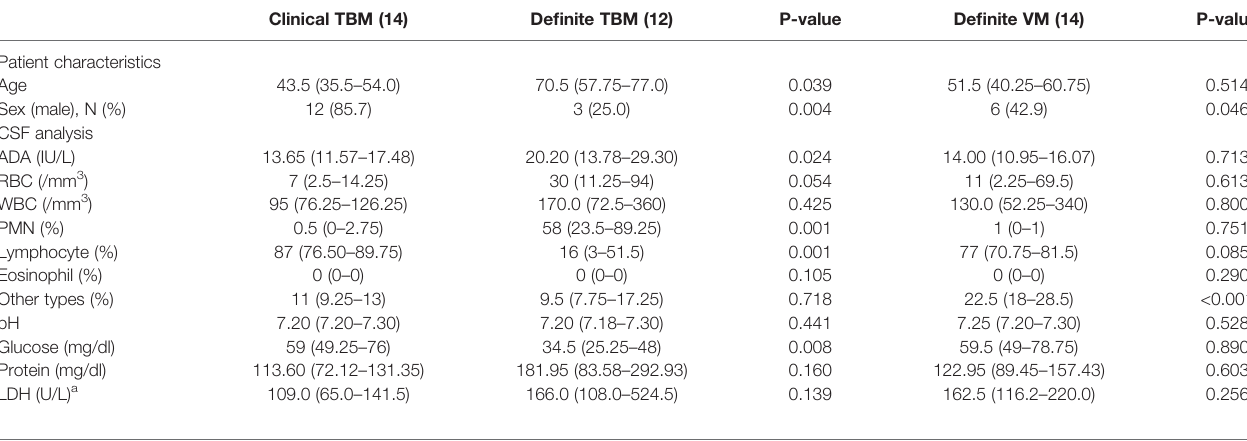
TABLE 2 | Patient characteristics and cerebrospinal fl uid analysis from the de fi nite diagnosis of viral meningitis and clinical diagnosis of tuberculous